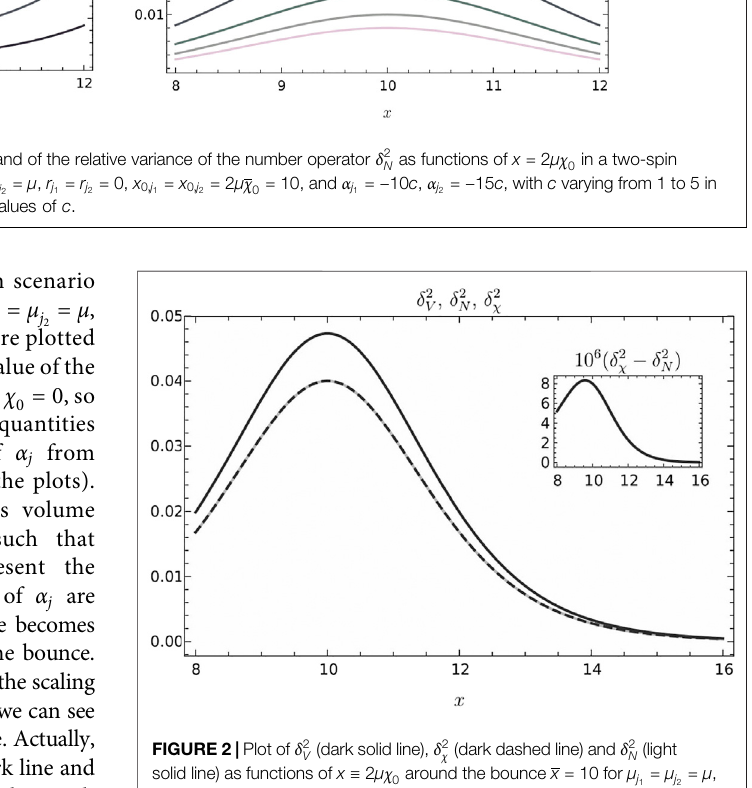
(cid:2) μ (cid:2) μ , j 2 1